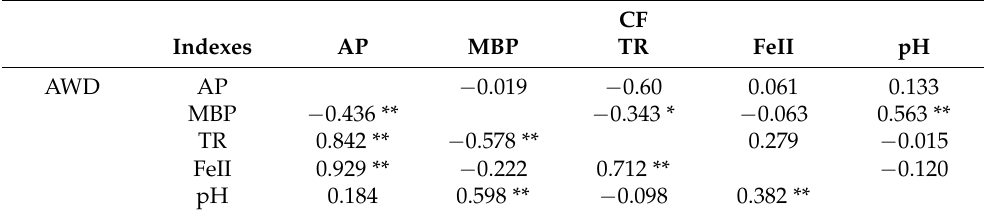
Table 1. Correlations between selected soil properties under continuous flooding irrigation (CF) and alternate wetting and drying irrigation (AWD).